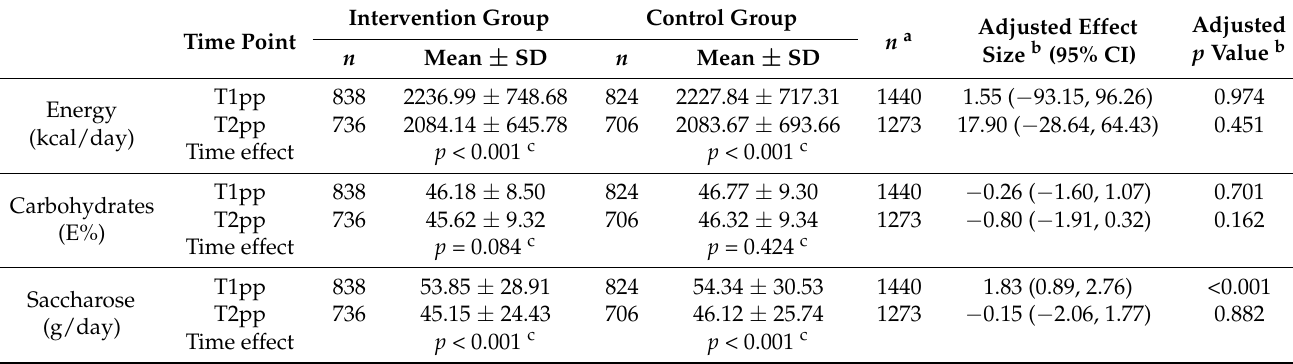
Table 4. Mean energy and macronutrient intake in the intervention and control